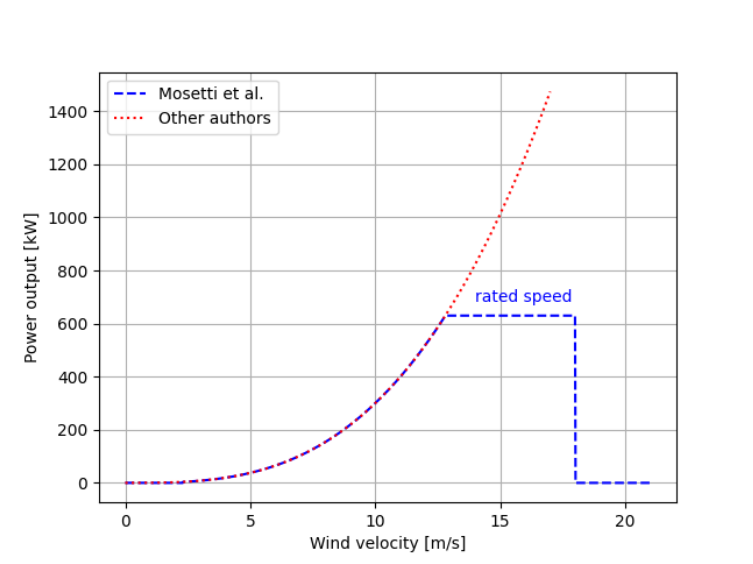
Figure 13. Power curve for cases 3 and 4.